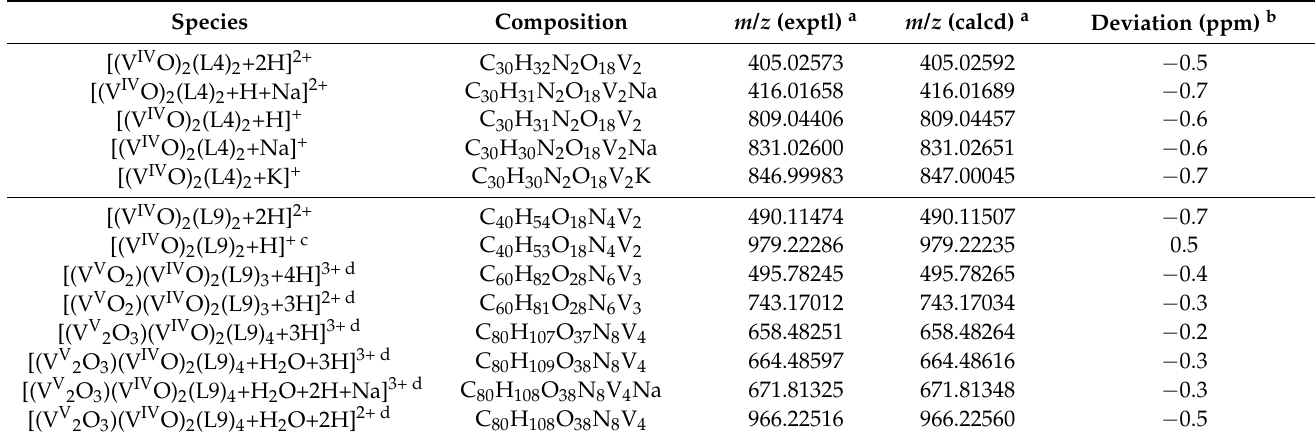
a Experimental and calculated m/z values refer to the monoisotopic peak with the highest intensity. b Error in ppm respect to the experimental value, calculated as 10 6 × [Experimental ( m/z )—Calculated ( m/z )]/Calculated ( m/z ). c Species detected only in the spectra recorded in MeOH. d Species detected only in the spectra recorded in H 2